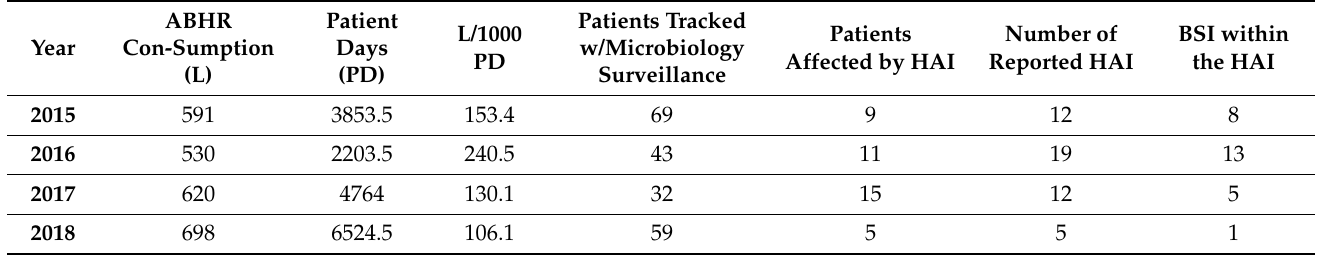
Table 2. Reported numbers of the NICU regarding handrub consumption and HAI. International recommendations denote >100 L/1000 patient days ABHR